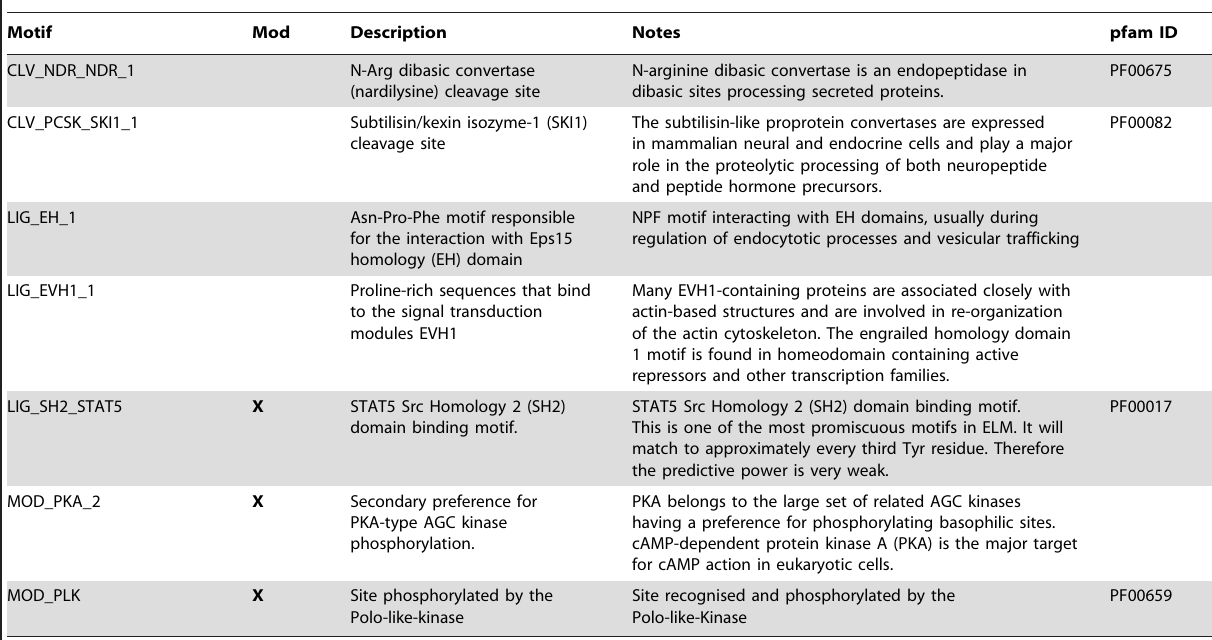
Table 2. List of ELM’s common to HEV genotypes 1–4 in the